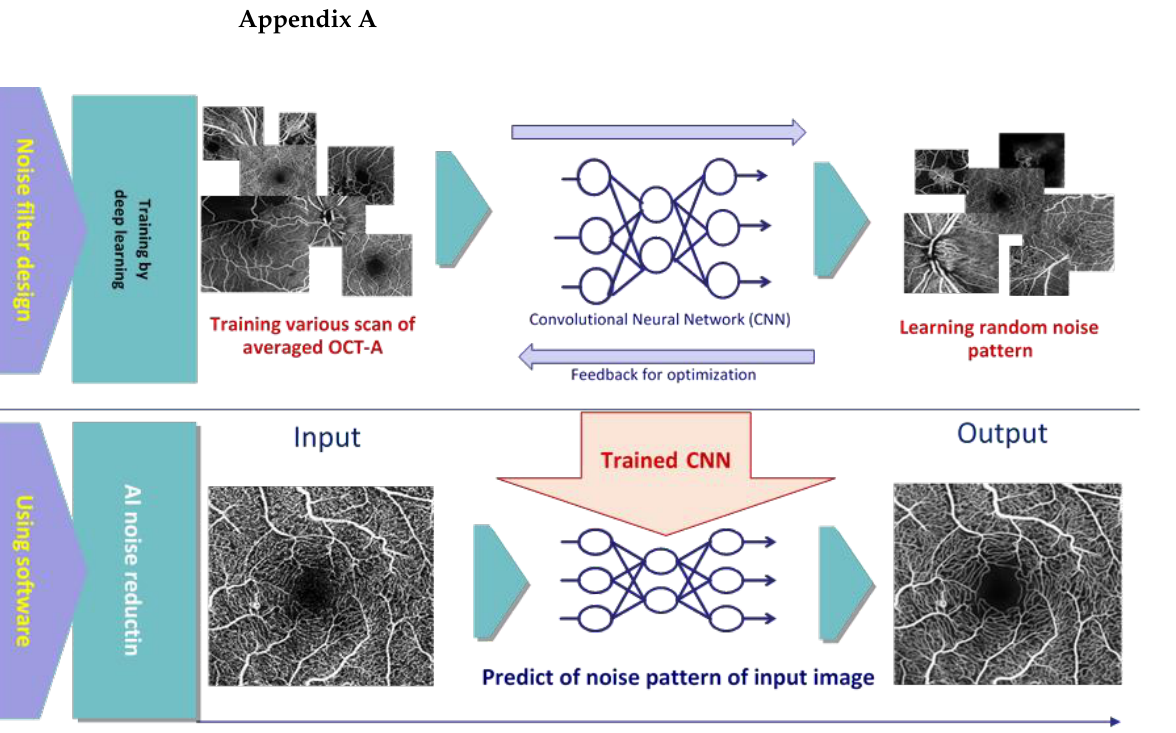
Figure A2. Proforma used by the retinal experts when comparing baseline to denoised OCT-A images. References 1. Moult, E.; Choi, W.; Waheed, N.K.; Adhi, M.; Lee, B.; Lu, C.D.; Jayaraman, V.; Potsaid, B.; Rosenfeld, P.J.; Duker, J.S.; et al. Ultrahigh-speed swept-source OCT angiography in exudative AMD. Ophthalmic Surg. Lasers Imaging Retin. 2014 , 45 , 496 – 505. 2.